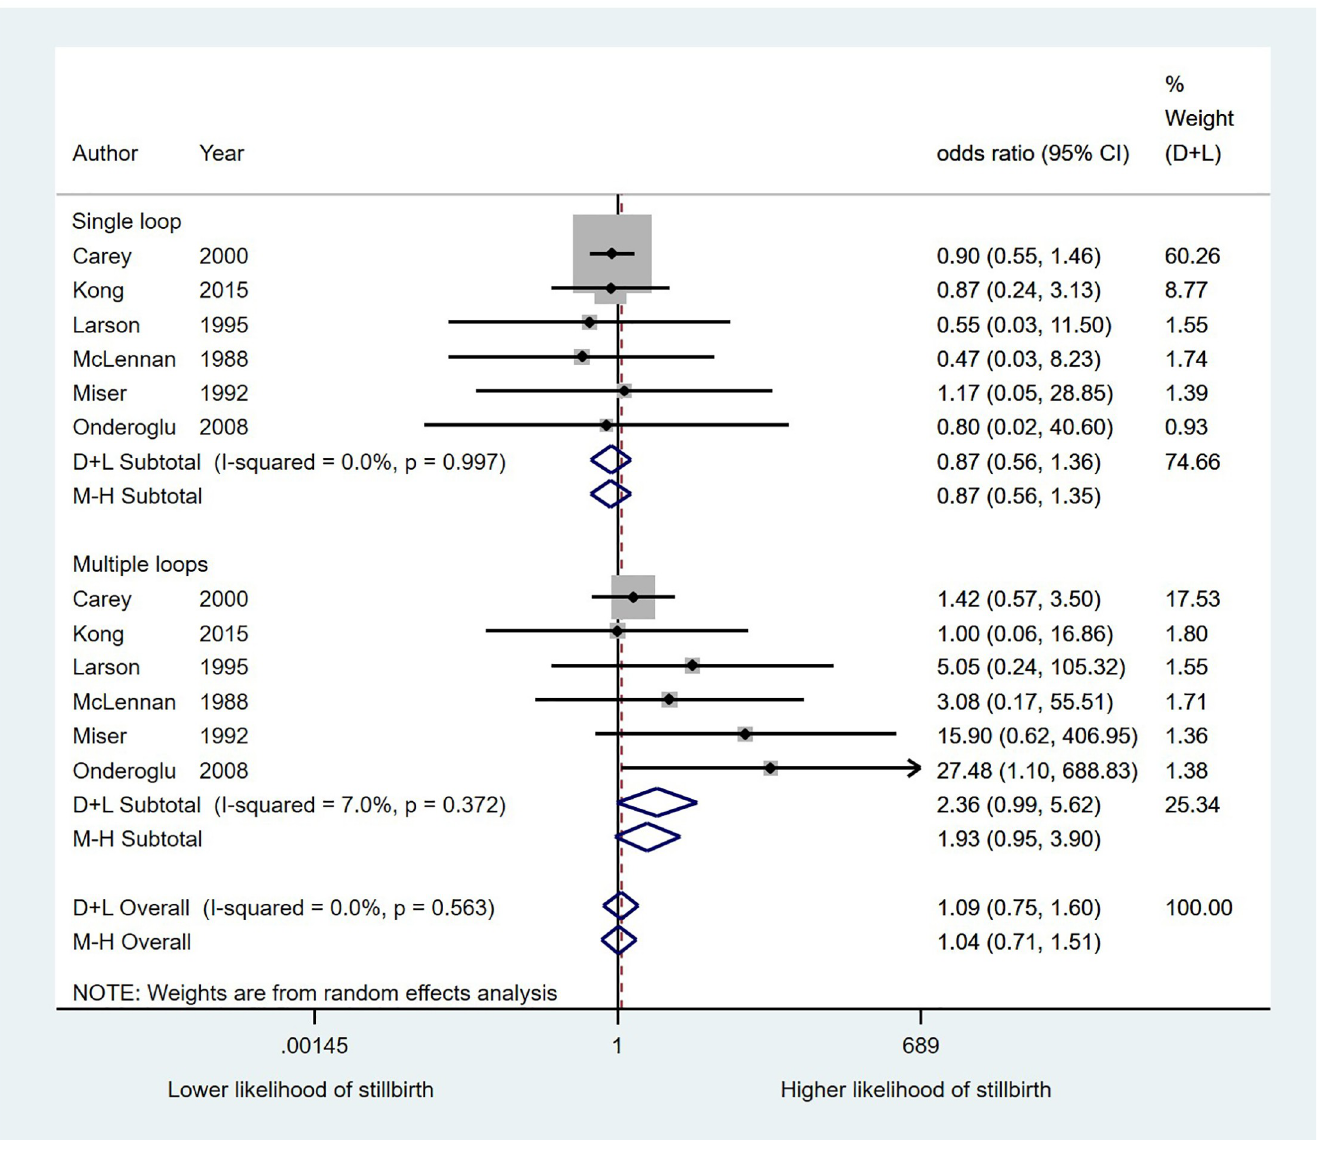
Fig 4. The association between nuchal cord loops and the likelihood of